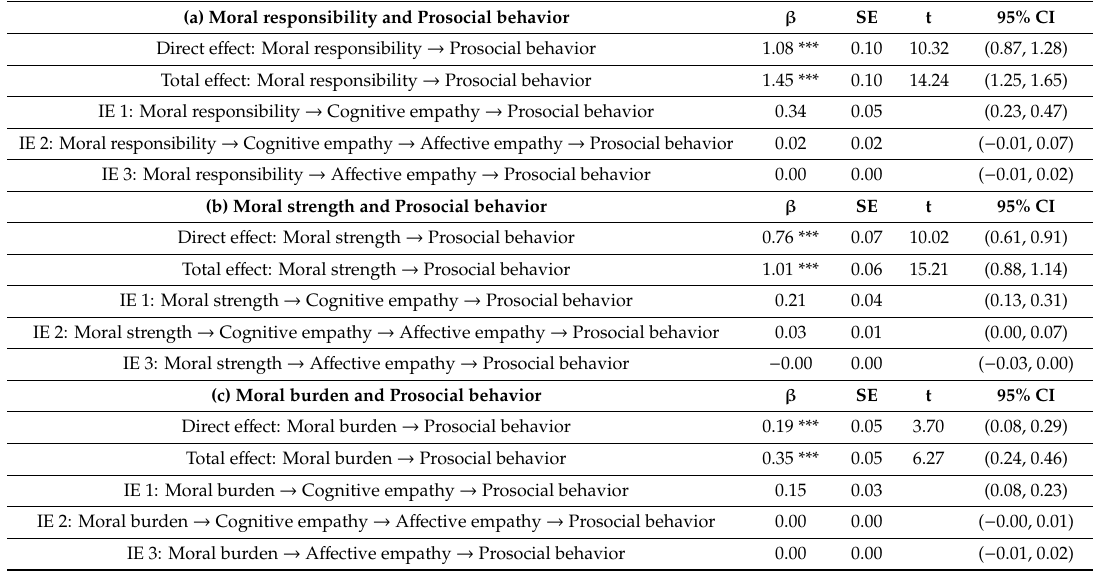
Table 3. Direct, total, and indirect e ff